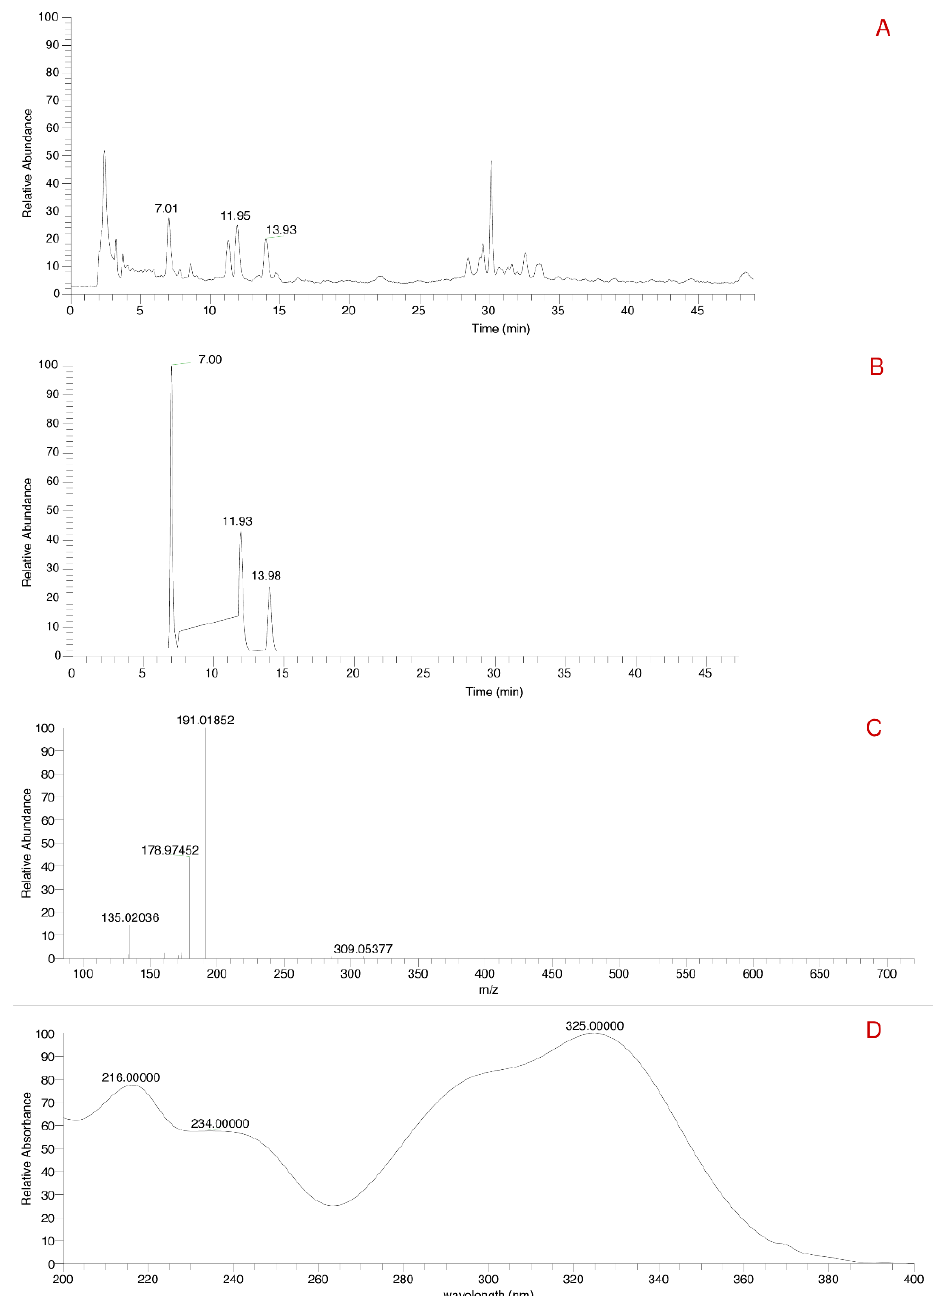
Figure 1. Chromatograms of V. album ethanolic dry extract. ( A )—total ion-chromatogram in nega- tive mode. ( B )—extracted total ion-chromatogram of chlorogenic acid in negative mode. ( C )— MS/MS spectra of chlorogenic acid. ( D )—absorption spectrum in the ultraviolet region of chloro- genic acid.